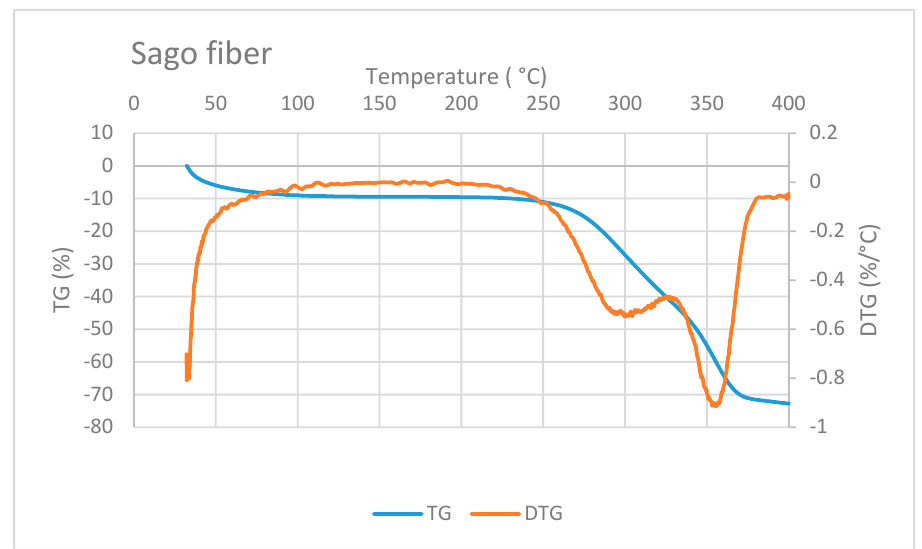
Figure 6. TG / DTG of sago fiber. Reduction of sago fiber mass occurs at two di ff erent temperature Figure 6. TG/DTG of sago fiber. Reduction of sago fiber mass occurs at two different temperature ranges. Two DTG peaks are correlated to hemicellulose and cellulose ranges. Two DTG peaks are correlated to hemicellulose and cellulose decomposition.